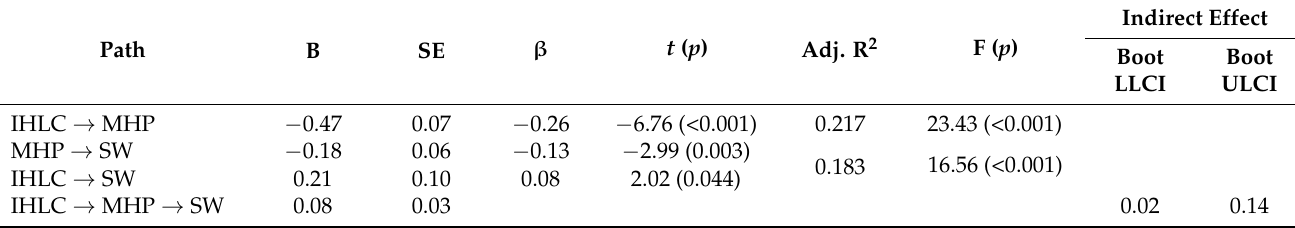
Table 3. Mediating Effects of Mental Health Problems in the Relationship between Internal Health Locus of Control and Subjective Well-Being ( n = 600).